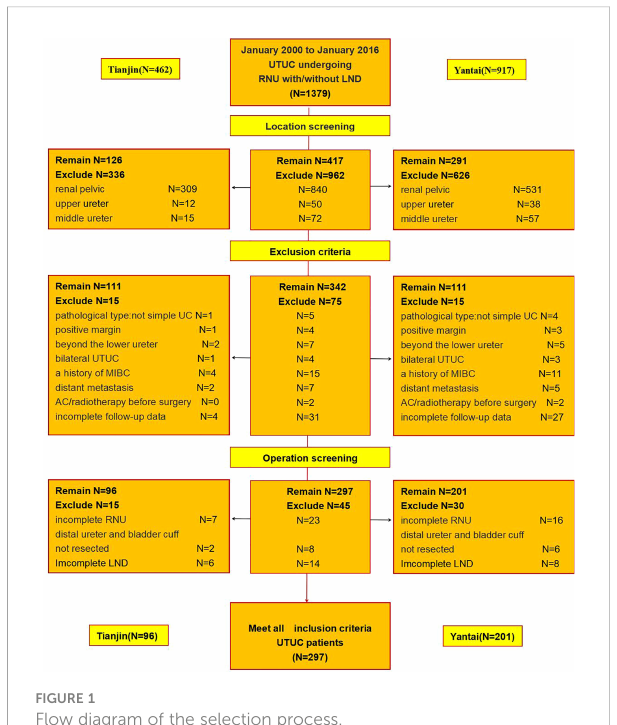
FIGURE 1 Flow diagram of the selection